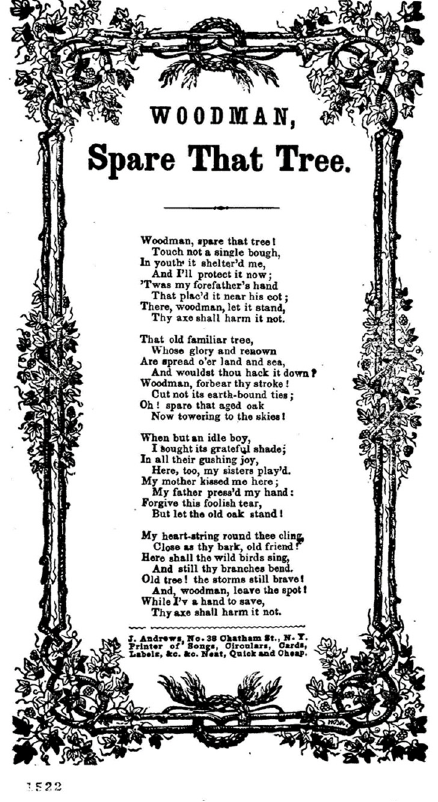
Figure 5. “Woodman, Spare That Tree ” by George P. Morris and Henry Russell, 1837. J. Andrews, No. 38 Chatham St., New York. Courtesy of the Library of Congress.